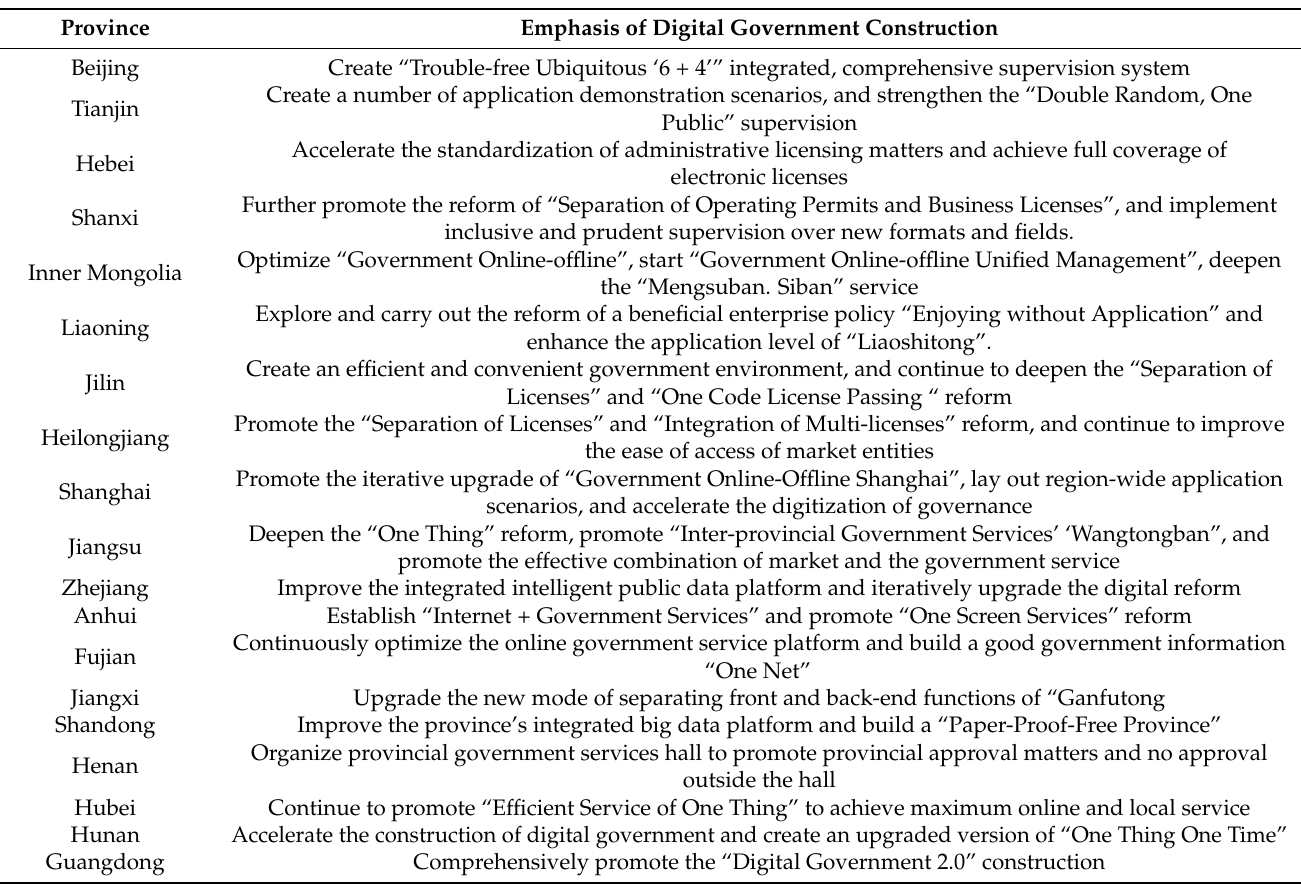
Table A1. Emphasis of digital government construction in China’s provinces in 2022